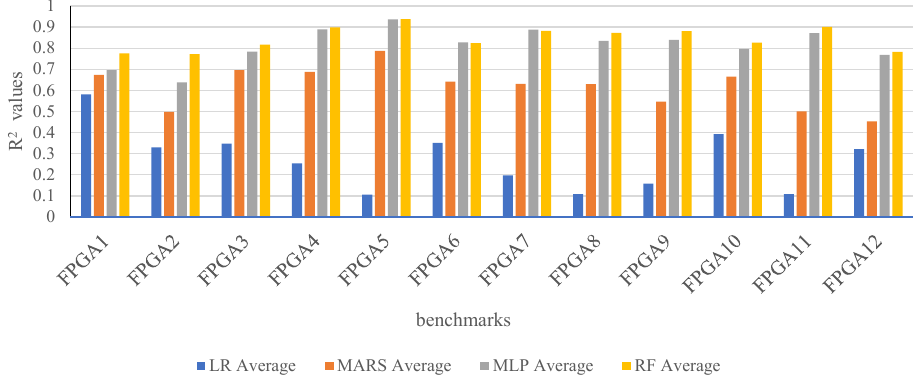
Figure 7. Average R 2 value for the 12 benchmarks using 4 regression models. LR: Linear Regression; MARS: Multivariate Adaptive Regression Splines; MLP: Multi Layer Perceptron; RF: Random